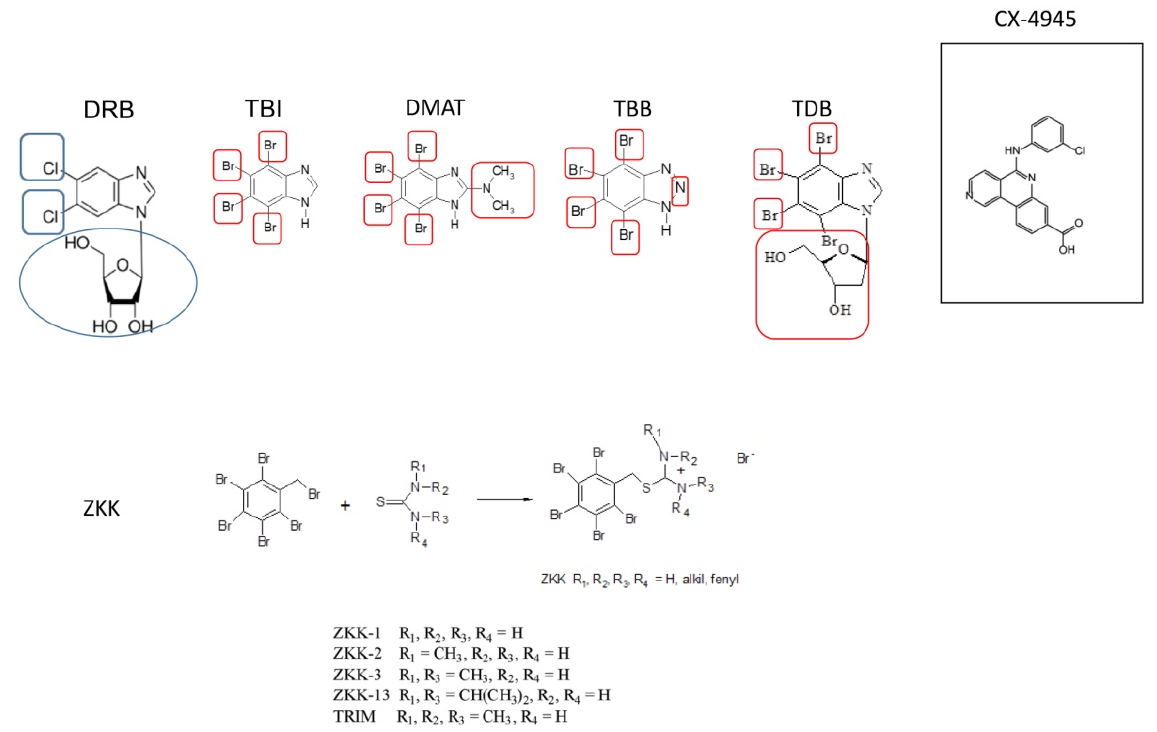
Figure 2. Chemical structure of DRB and its derivatives, CX-4945 and ZKK, with encircled modifications of DRB structure. Modifications that nucleoside DRB underwent included the deletion its sugar moiety and the replacement of the chlorine and hydrogen atoms of its benzene ring. Encircled among others are bromine atoms that are critical for encapsulating inhibitors in the hydrophobic cavity of CK2. The bottom panel shows the chemical synthesis of ZKK.